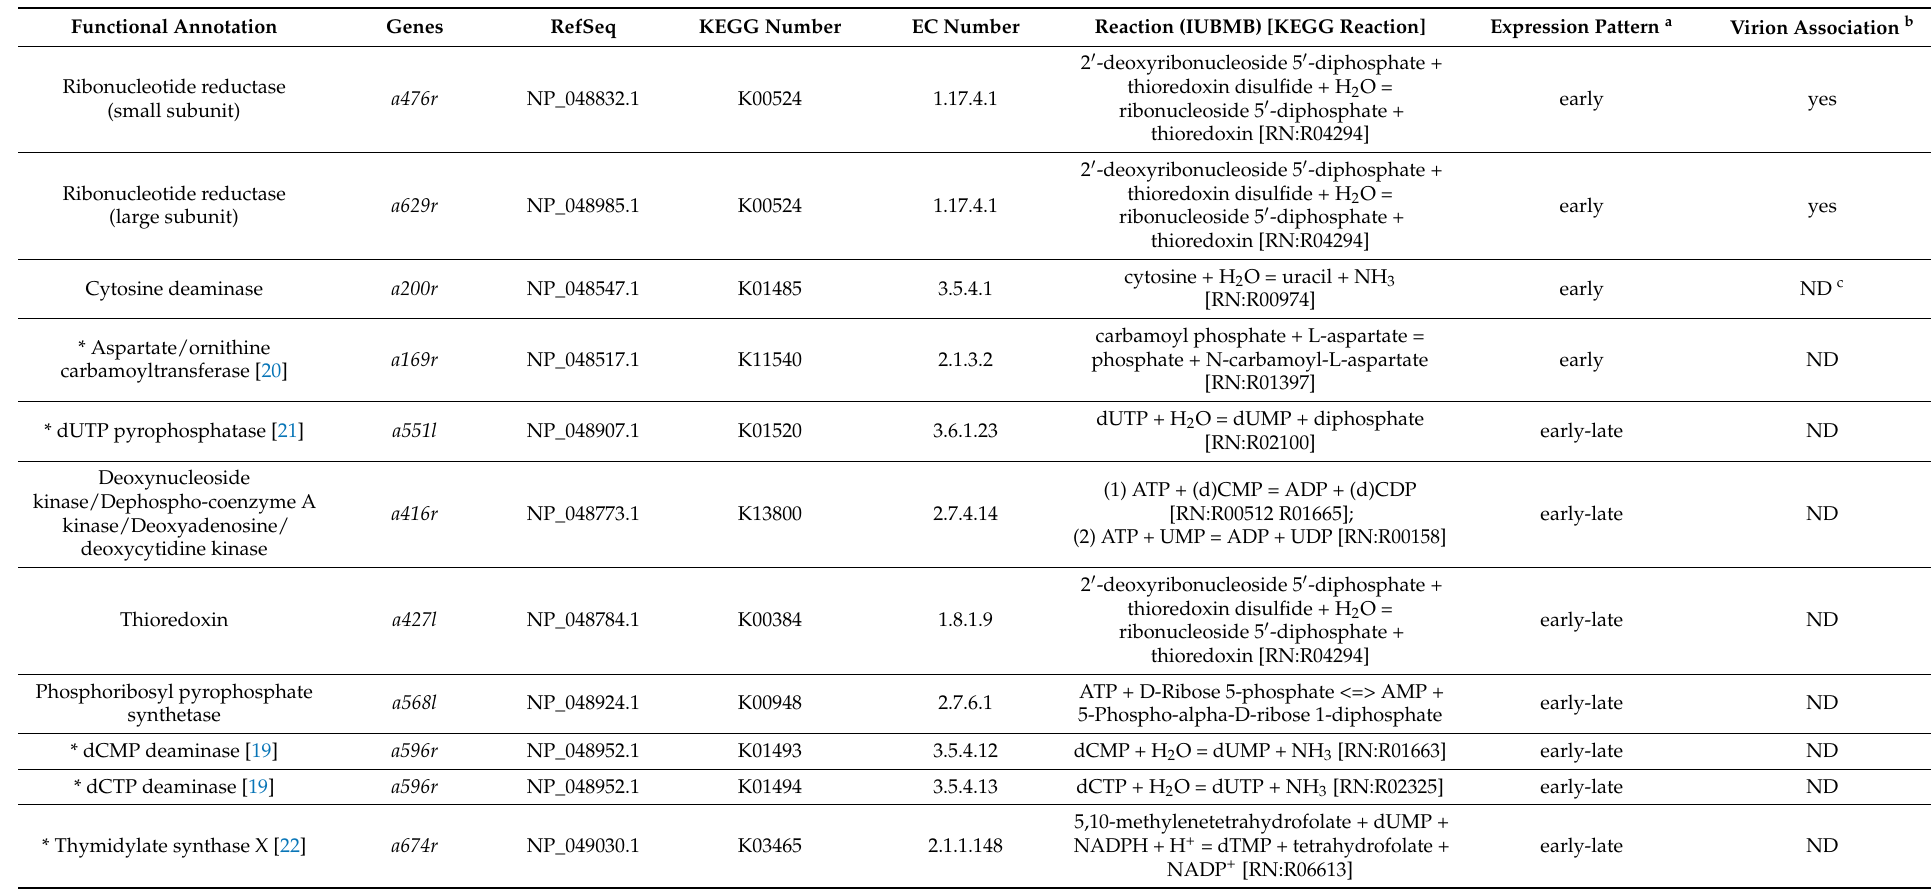
Table 1. Functional annotations of PBCV-1 nucleotide metabolism genes, ordered by infection cycle